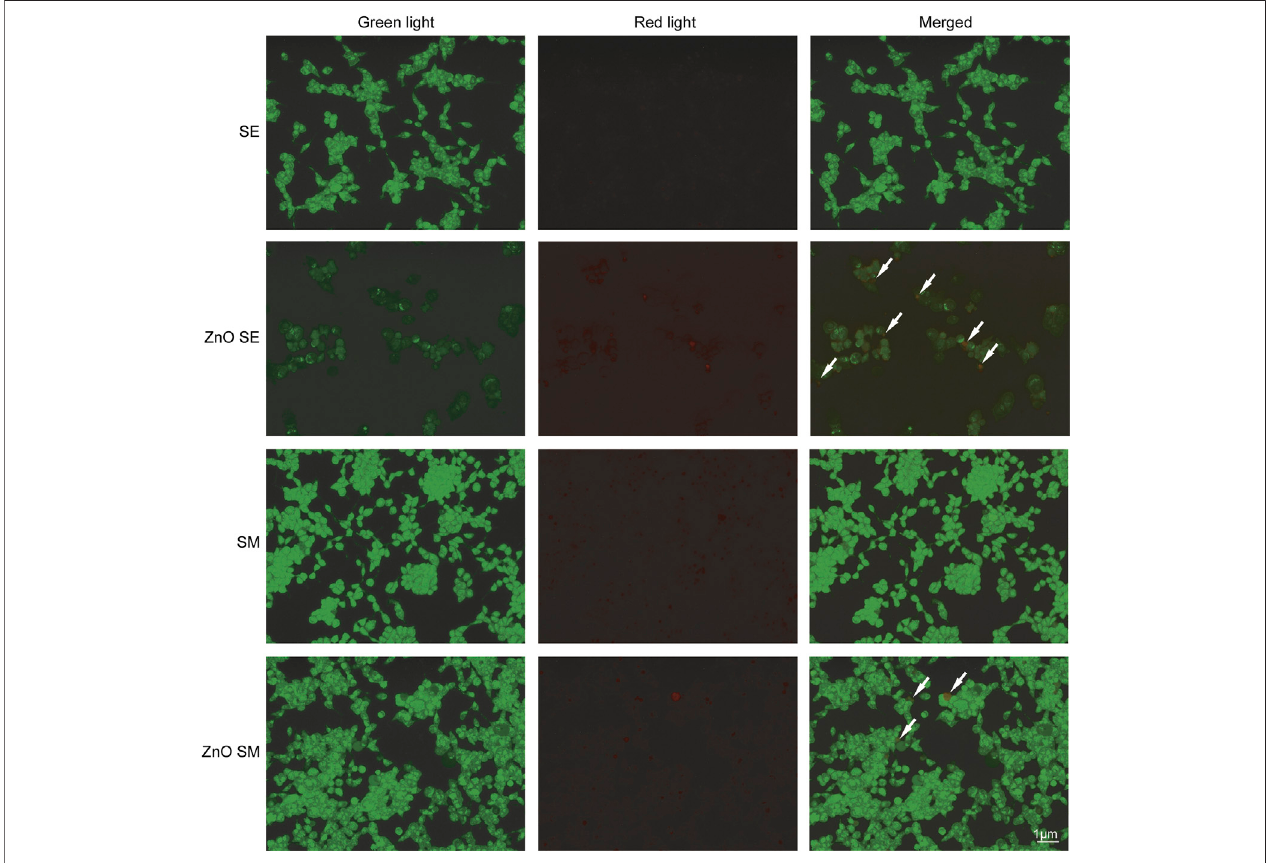
FIGURE 8 | Acridine orange (AO) staining. Acridine orange staining of Caco-2 cells to detect apoptosis. Live cells are uniformly green, whereas apoptotic cells are stained orange-red due to chromatin condensation and loss of membrane integrity. Pictures were taken at magni fi cation of × 40.